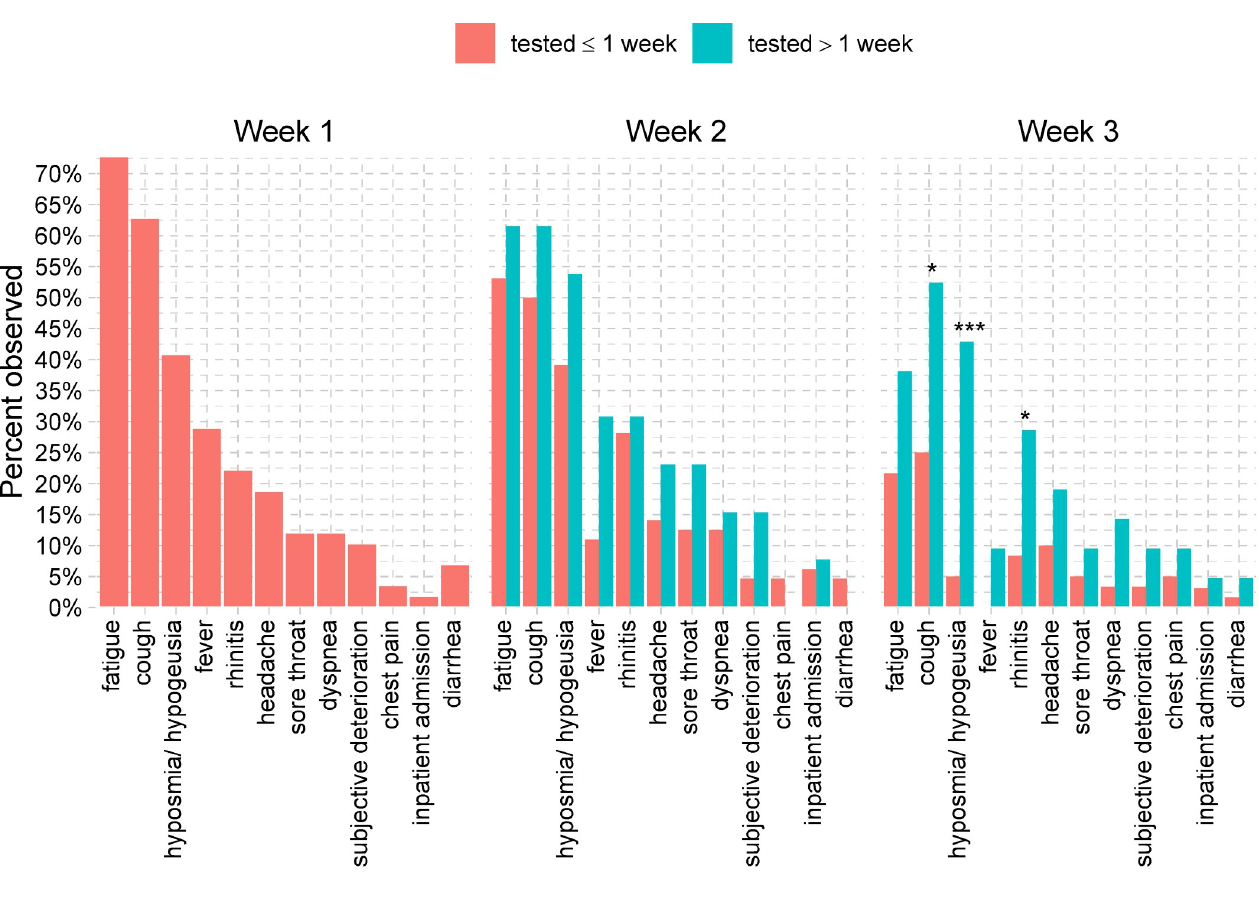
Fig 3. Symptoms in the first three weeks after symptom onset for patients presenting early ( � 7 days after symptom onset) or late ( > 7 days after symptom onset). Symptoms typically persisted longer in late presenters compared to early presenters. This was observed strongest for hyposmia/hypogeusia (p < 0.001, FDR < 0.05, indicated by ��� ), cough and rhinitis (p < 0.05, FDR < 0.3, indicated by �